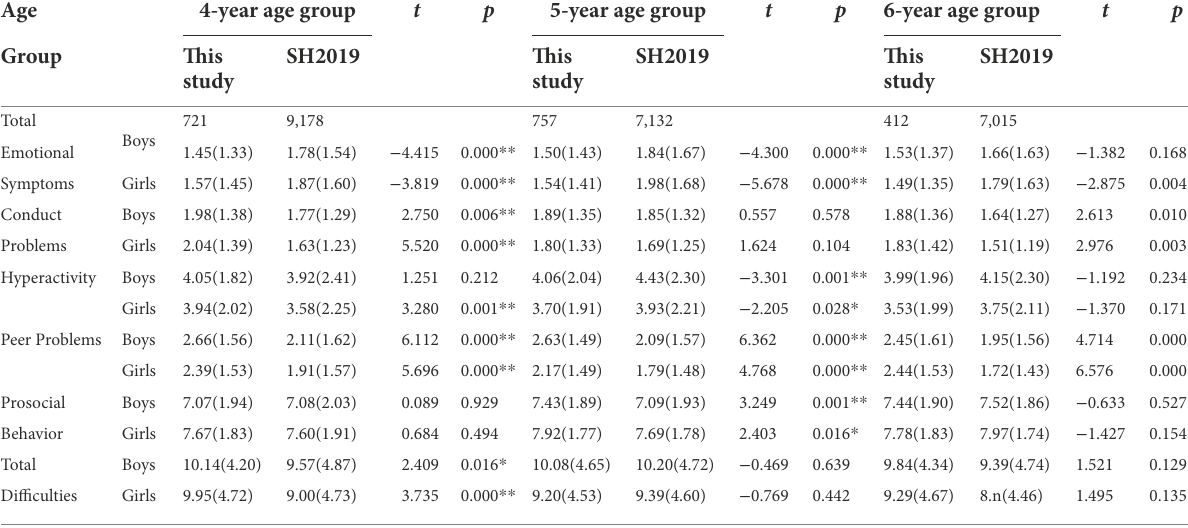
TABLE 4 Comparison of preschool children’s SDQ scores with SH2019.